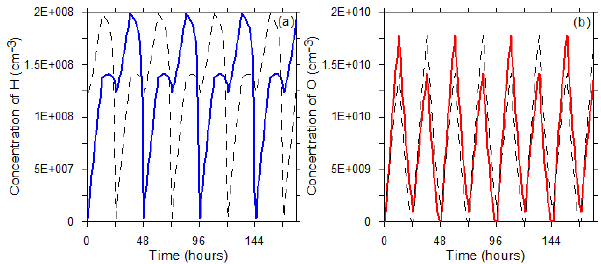
Fig. 2. Oscillations of H and O concentrations ( a and b , respec- tively) at a height of 85km (solid curves). Dashed curves are for the oscillations of these variables with another value of initial